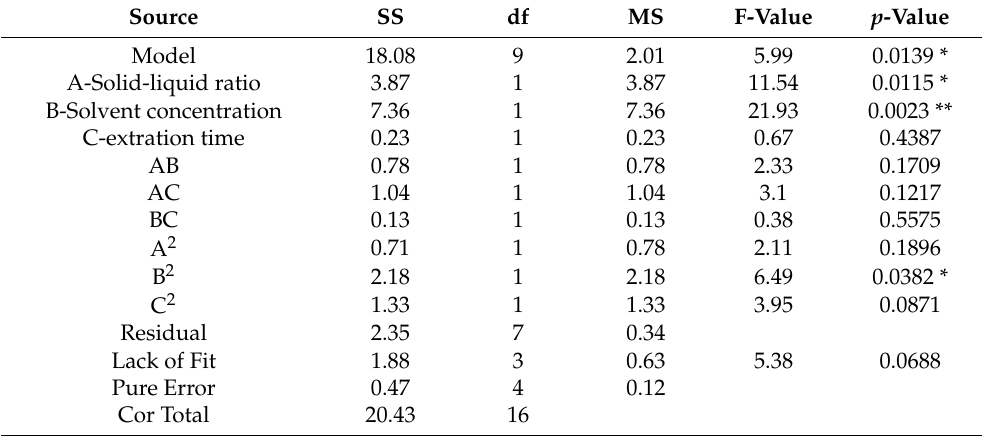
Table 6. Analysis of variance for the fitted quadratic polynomial model for recovery of compos- ite